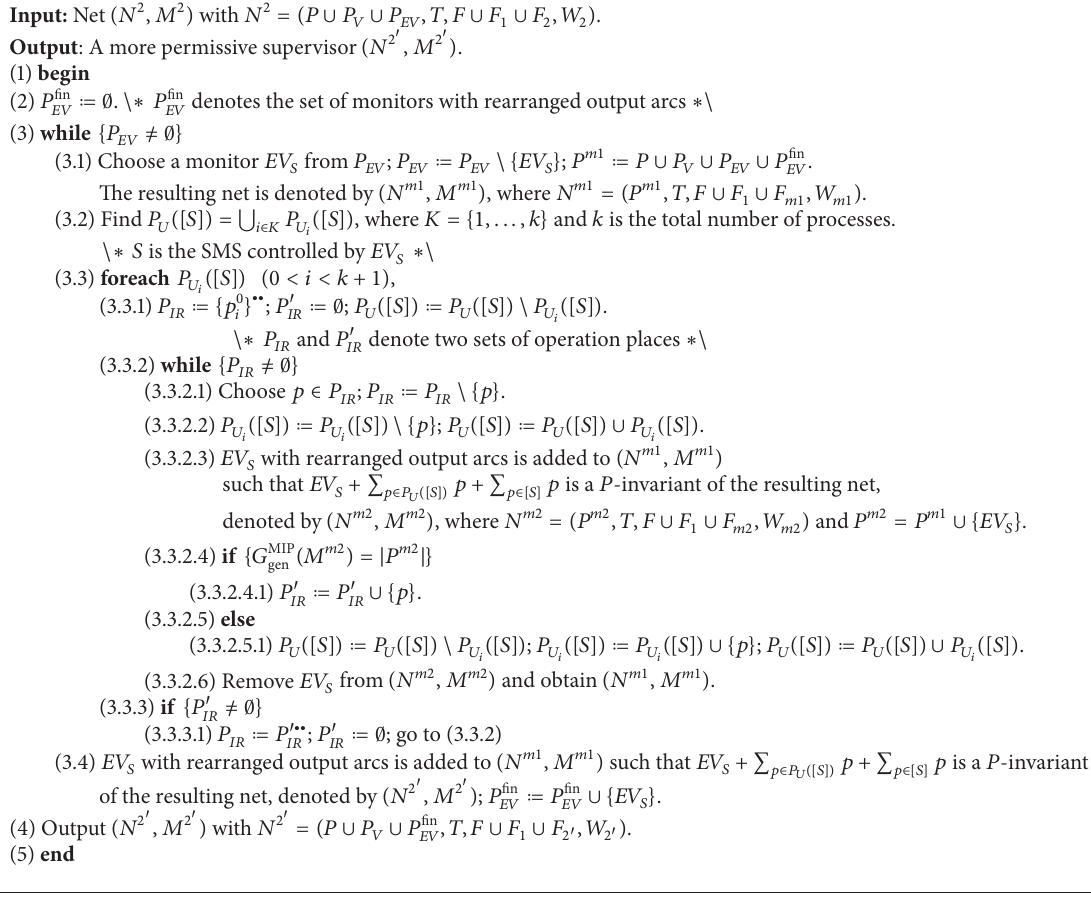
Algorithm 2: Synthesis of a more permissive supervisor.